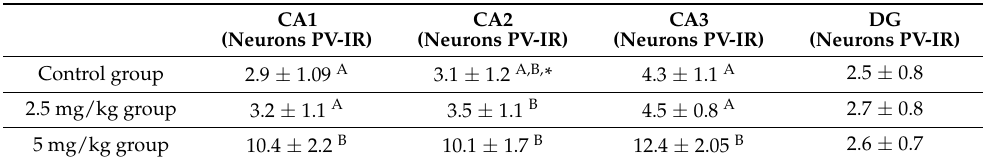
Table 1. Average numbers of PV-IR neurons in the CA1, CA2, and CA3 hippocampal fields and DG of mice from the control and experimental groups: 5 and 2.5 mg/kg BBR (i.p.). CA1 (Neurons PV-IR)